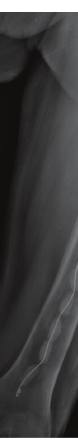
Figure 5: Medullary cavity of the femur filled with custom-made vancomycin beads.